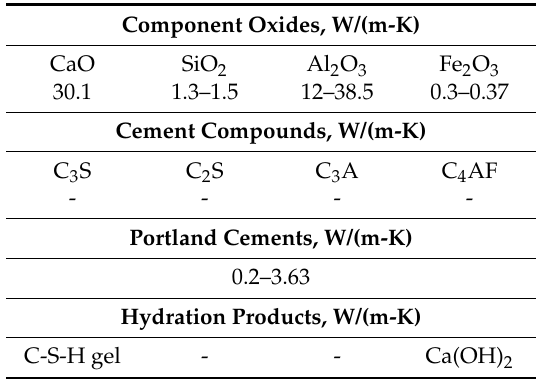
Table 1. Thermal conductivities of cement